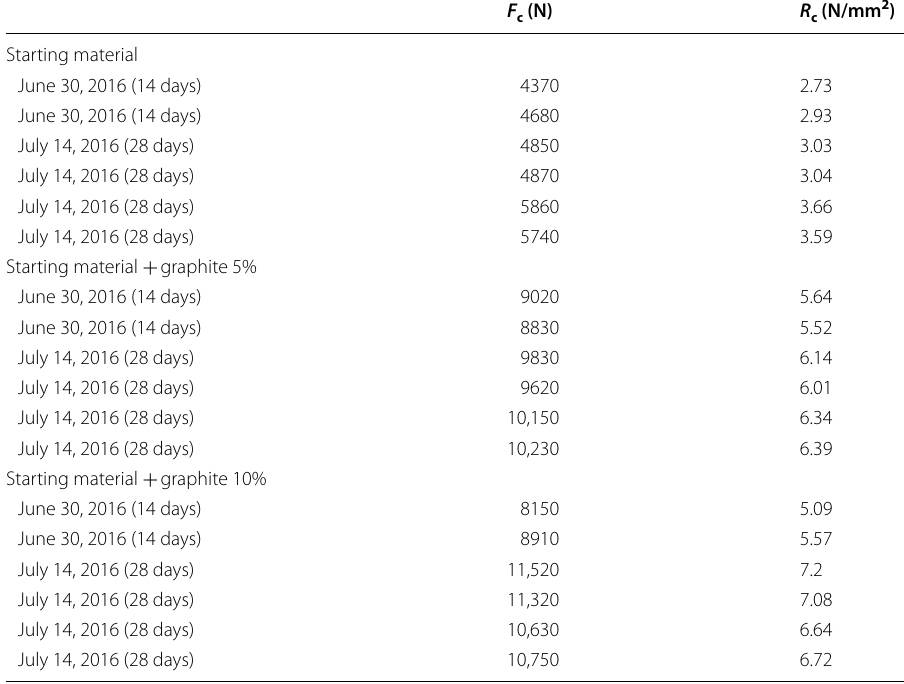
F c indicates the load applied at the fracture point. Dates indicate times between preparation and realization of the mechanical tests (at 14 and 28 days)